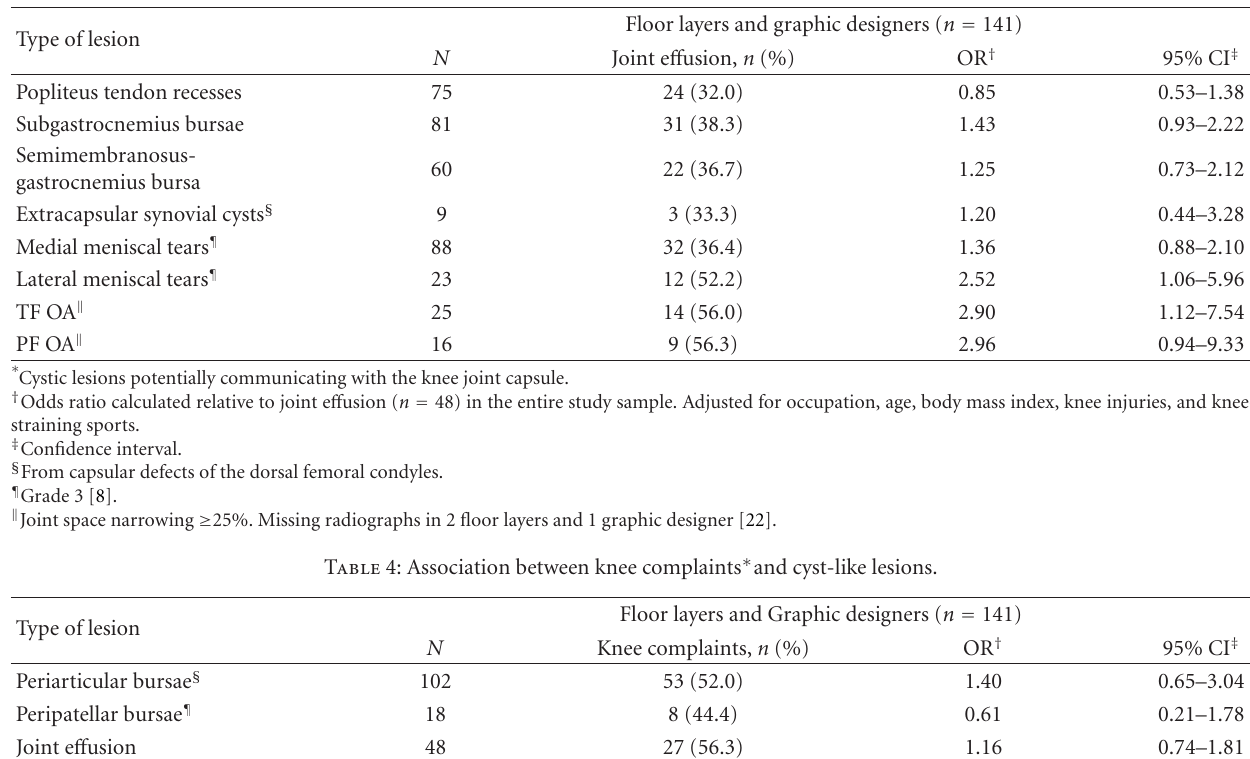
∗ Odds ratio calculated relative to graphic designers. Adjusted for age, body mass index, knee injuries, and knee-straining sports. † Confidence interval. ‡ Medial and lateral collateral ligament, biceps femoris, semimembranosus-gracilis. § From capsular defects of the dorsal femoral condyles. ¶ Anterior cruciate ligament. (cid:4) Posterior cruciate ligament. Table 3: Association between knee joint e ff usion and cyst-like lesions ∗ , meniscal tears, and radiographic tibiofemoral (TF), and patellofemoral (PF) osteoarthritis (OA).